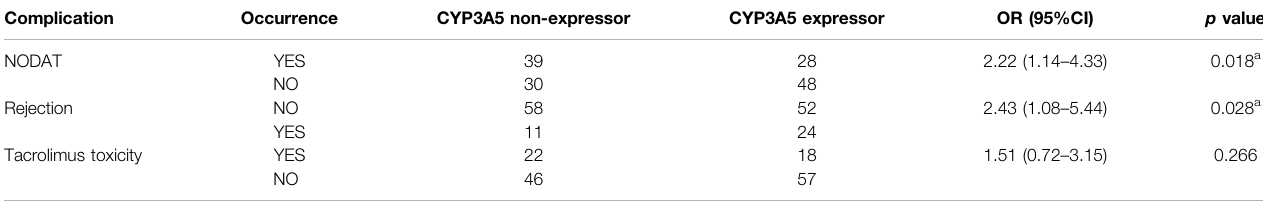
TABLE 6 | Association of CYP3A5 expressor status with post-transplant complications.